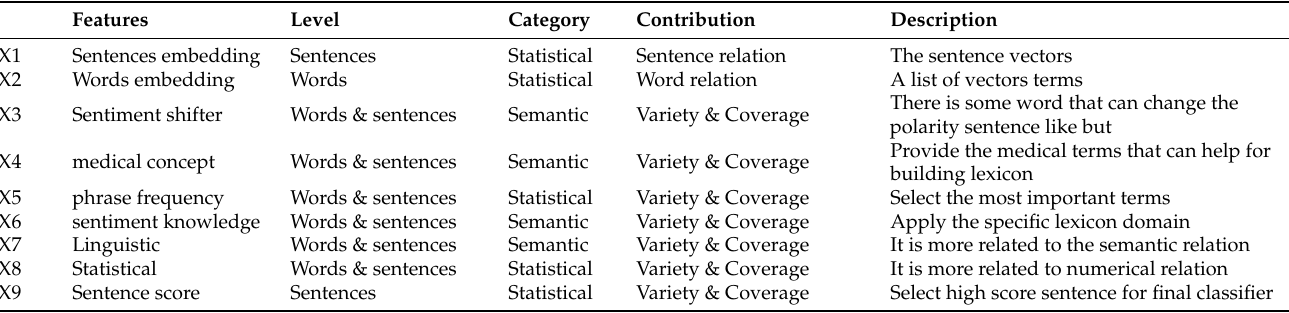
Table 2. Presented list of